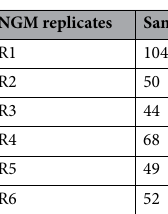
Table 1. Sample size and number of plates are indicated for each independent assay with wild-type C. elegans strain N2 in standard growth conditions (NGM plates).